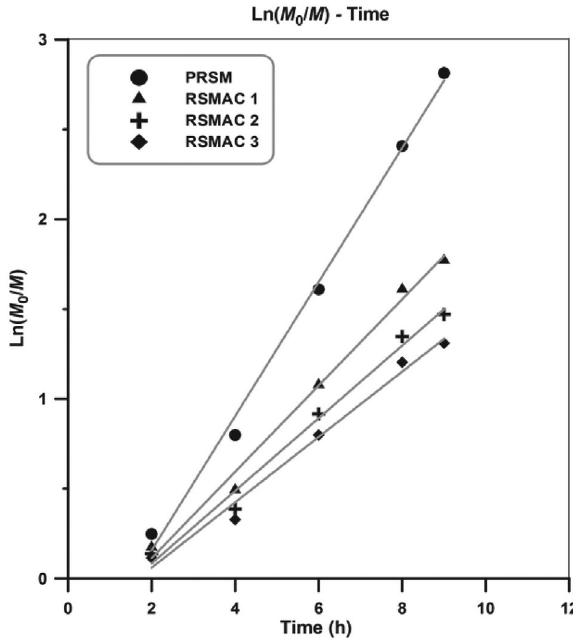
Figure 8. Kinetic plots with respect to the reaction time Figure 9. SEC traces of the neat random poly) styrene-co-methyl methacrylate) and its nanocomposites